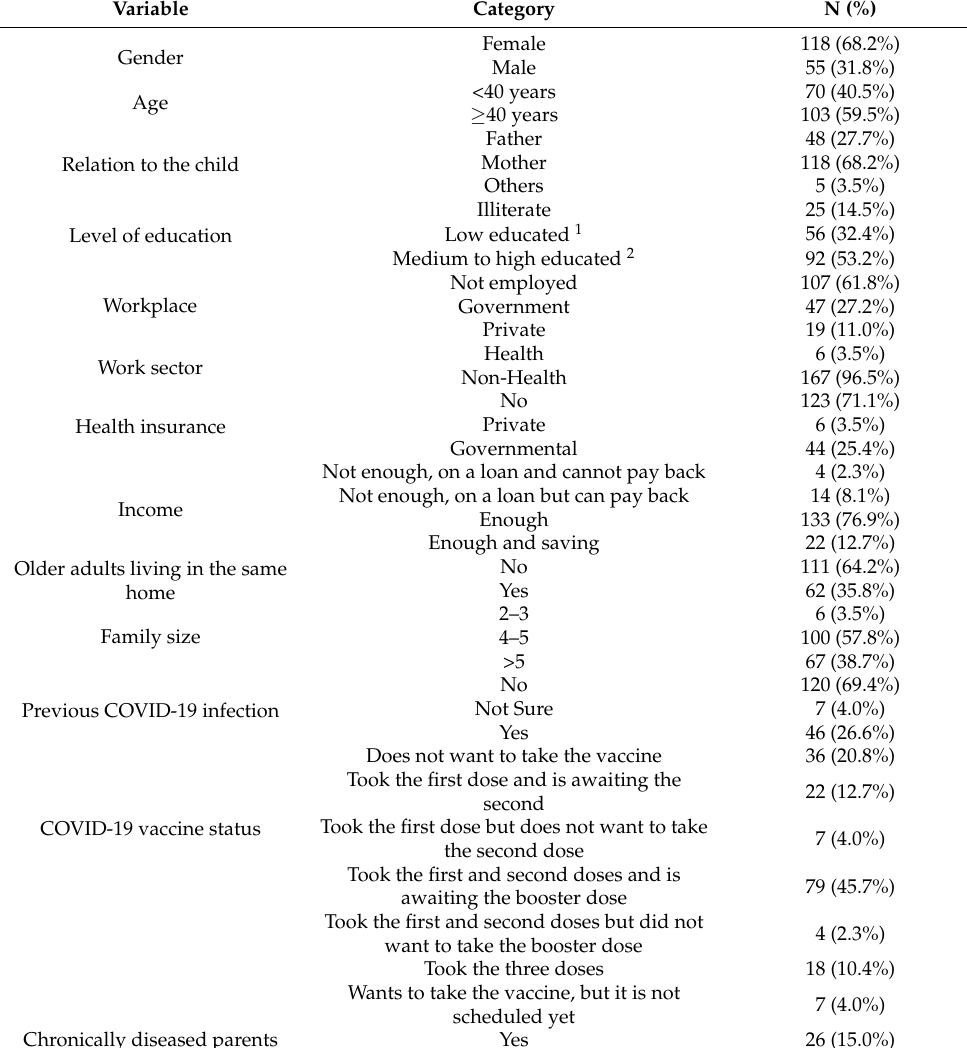
Table 1. Characteristics and COVID-19 related data of parents ( n =